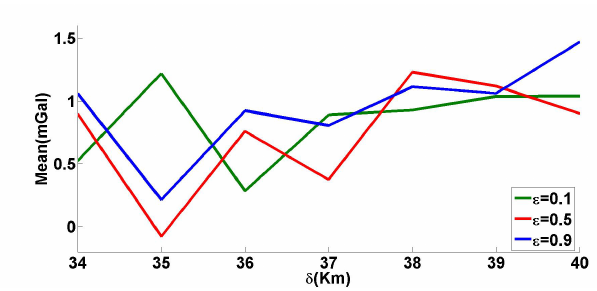
Fig. 7. Mean of the differences between SMLS approximated values and those from shipborne gravimetry, as a function of δ , Gaussian weight function, ϵ = 0.1, 0.5, 0.9